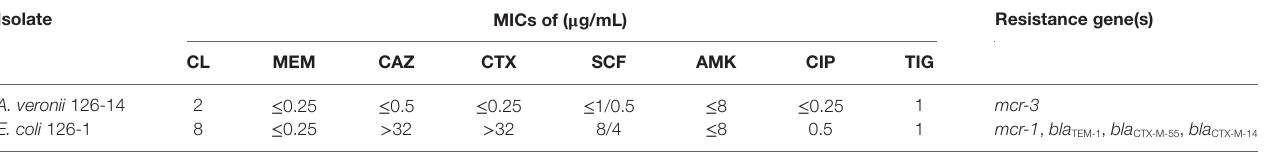
TaBle 2 | MICs and resistance gene profiles of mcr-3 -positive Aeromonas veronii 126-14 and mcr-1 -positive Escherichia coli 126-1.